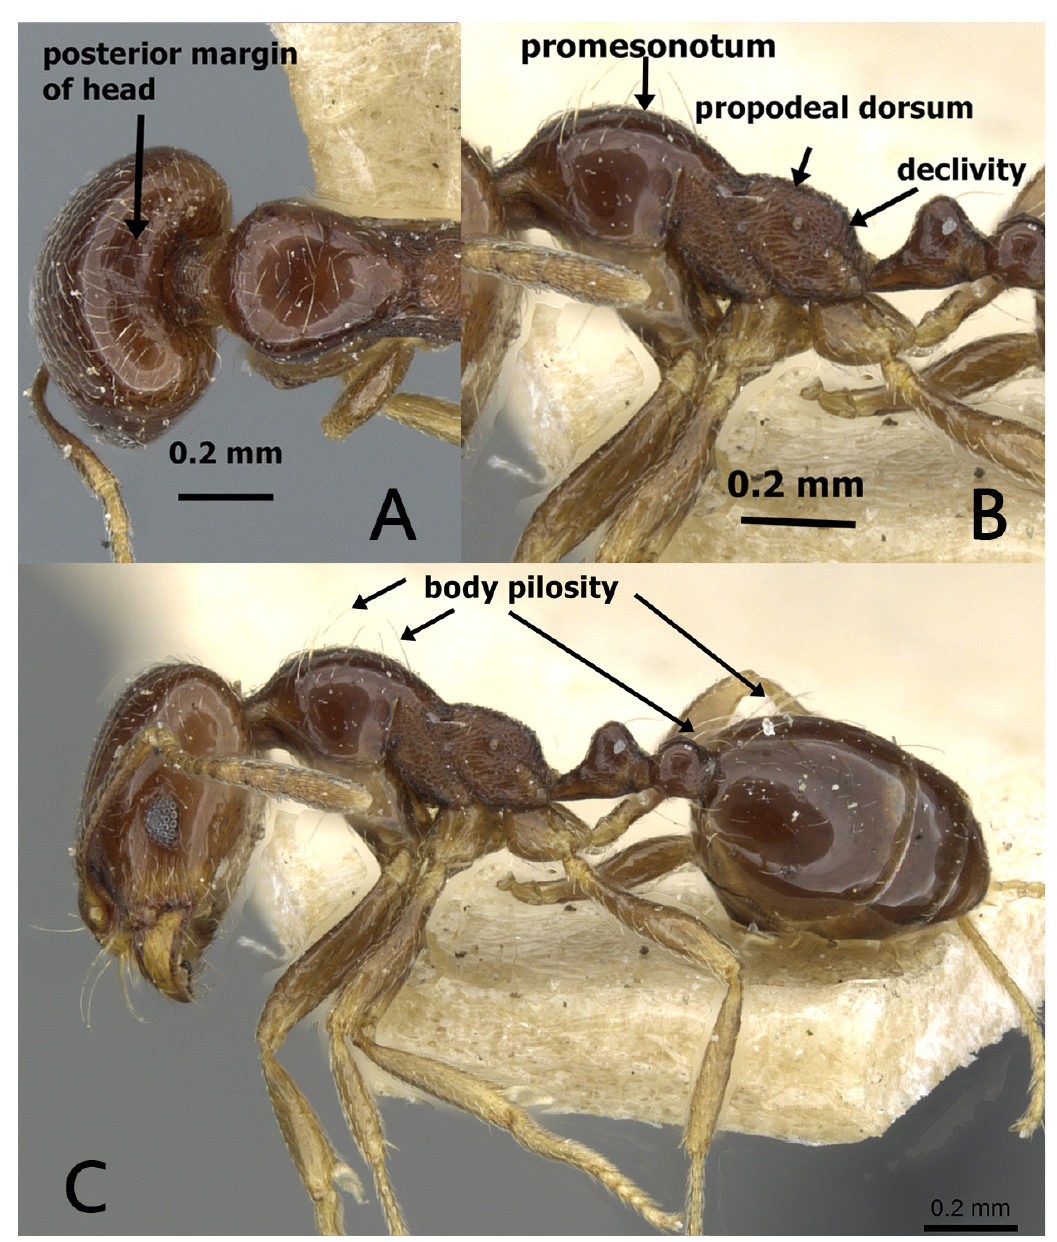
Fig. 4. Trichomyrmex robustior (Forel, 1892). A . Posterior margin of head in dorsal view. B . Mesosoma in profile. C . Body in